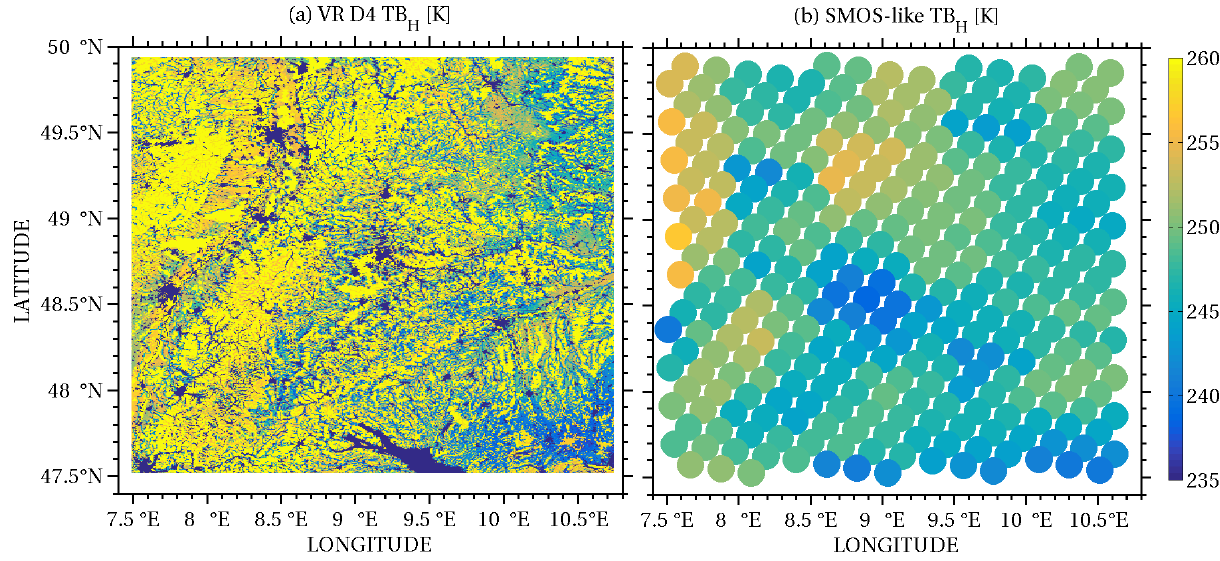
Figure A3. Brightness temperature calculated by the application of CMEM (H polarization) on the simulated-reality output on 2 July 2011 (a) and its aggregation on the spatial resolution of the L1C data product SMOS passive microwave radiometer (b) .